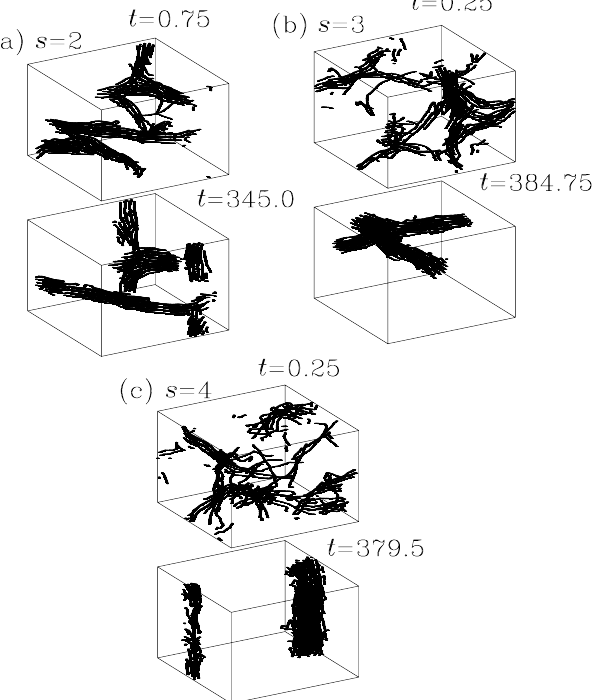
Figure 7. Plots of two typical snapshots of the 40 polymer chains, for each of the three systems with shared s A = − 4 and with distinctive s , ( a ) s = 2; ( b ) s = 3; ( c ) s = 4. The snapshot on the top of each plot is one in approaching to thermal equilibration between polymer and background fluid. The configuration shows that the aggregation of polymer chains proceeds as well. The snapshot on the bottom of each plot displays a steady configuration near the completion of the aggregation. We put, in each plot, the corresponding time spot in Fig. 6 for each of these